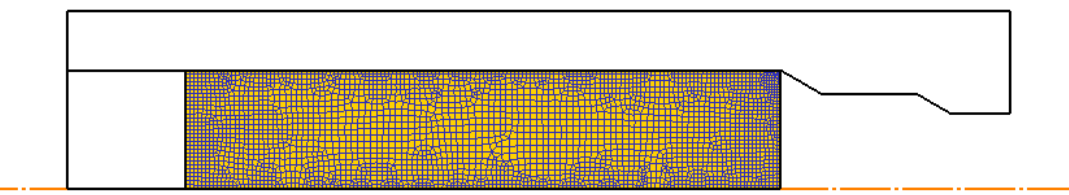
Figure 4. Mesh and geometrical configuration at the initial step before extrusion starts ( α = 30°, R T = 0.6, R A / R T = 60%, L / d 0 = 0.4).